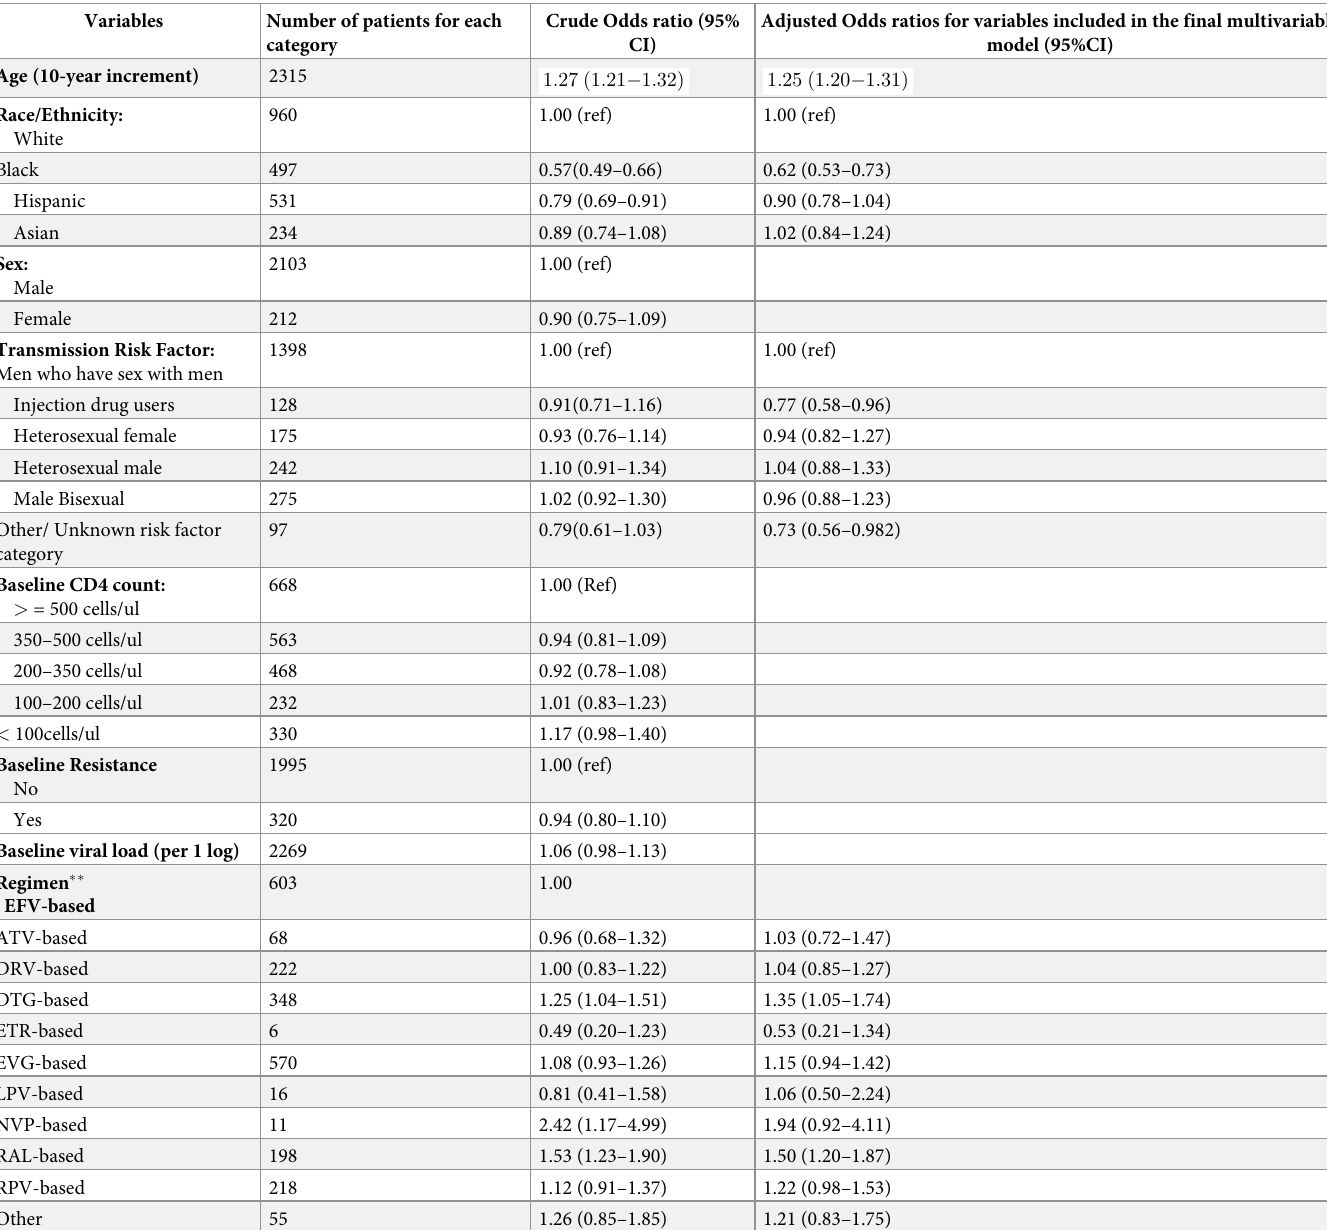
Table 2. Baseline predictors of longitudinal adherence among adult patients living with HIV initiating treatment at KPNC from 2010 to 2017 � . Variables Number of patients for each Crude Odds ratio (95% Adjusted Odds ratios for variables included in the final multivariable category CI) model